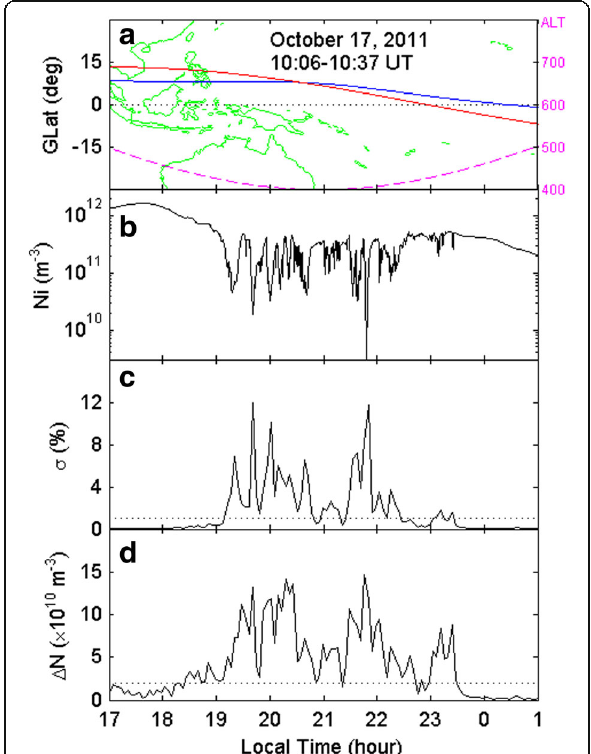
Fig. 1 Example of equatorial ionospheric irregularities measured by the Communication/Navigation Outage Forecasting System (C/ NOFS) satellite on 17 October 2011. Figure 1 a – d show the C/NOFS orbit, the ion density, the standard deviation of ion density variations ( σ ), and the ion density perturbations ( Δ N ),